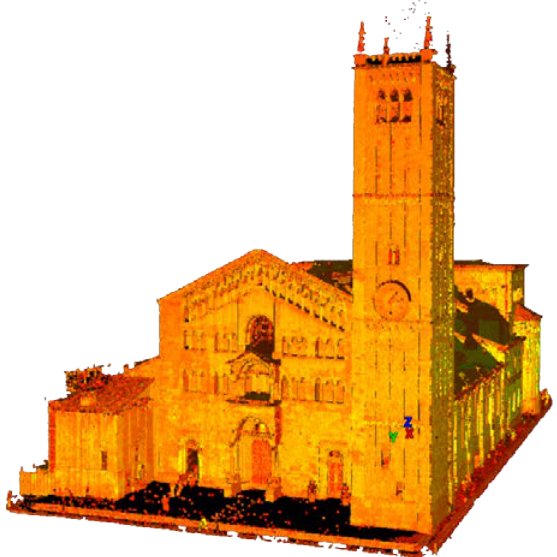
Figure 4_The complete point cloud after registration.